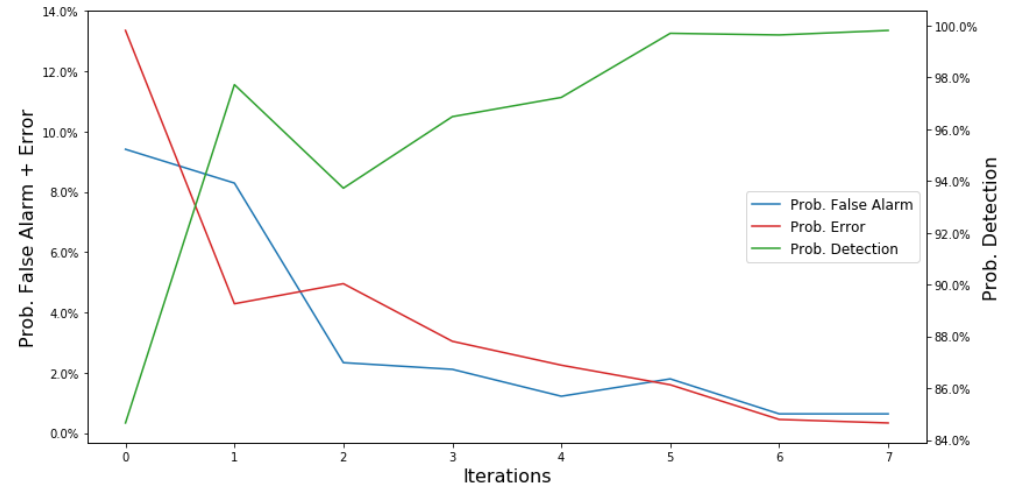
Figure 10. Behavior of the detection probability, the probability of false alarm, and the error probability, all estimated using the test set, as functions of the iteration